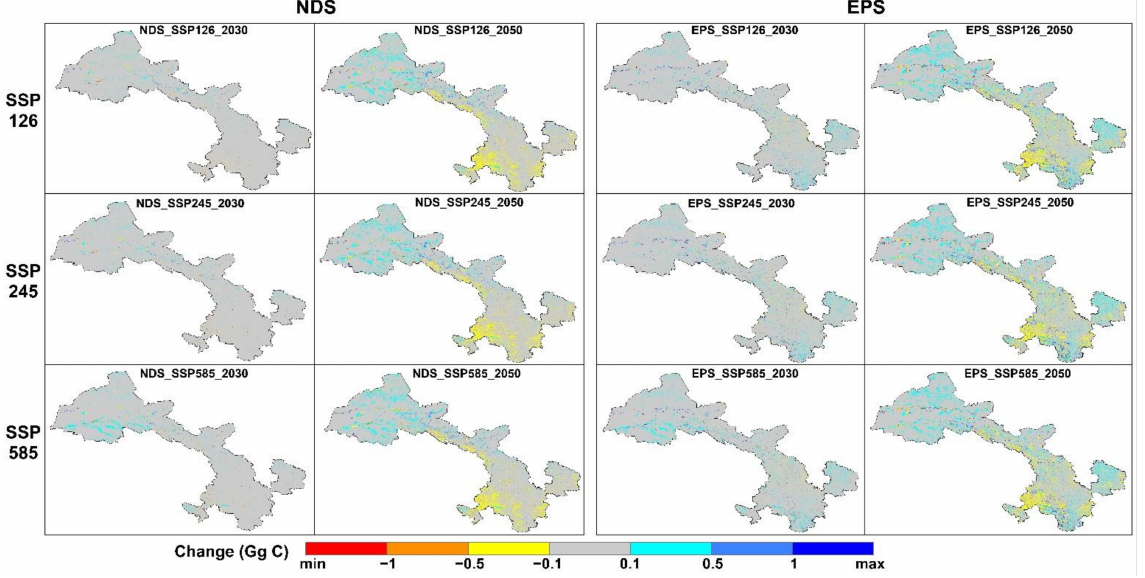
Figure 7. The spatial changes of the carbon storage across the Gansu province in the future periods (2030 and 2050) under the LUTC Scenarios (NDS and EPS) and Future Climate Scenarios (SSP126, SSP245, and SSP585) relative to